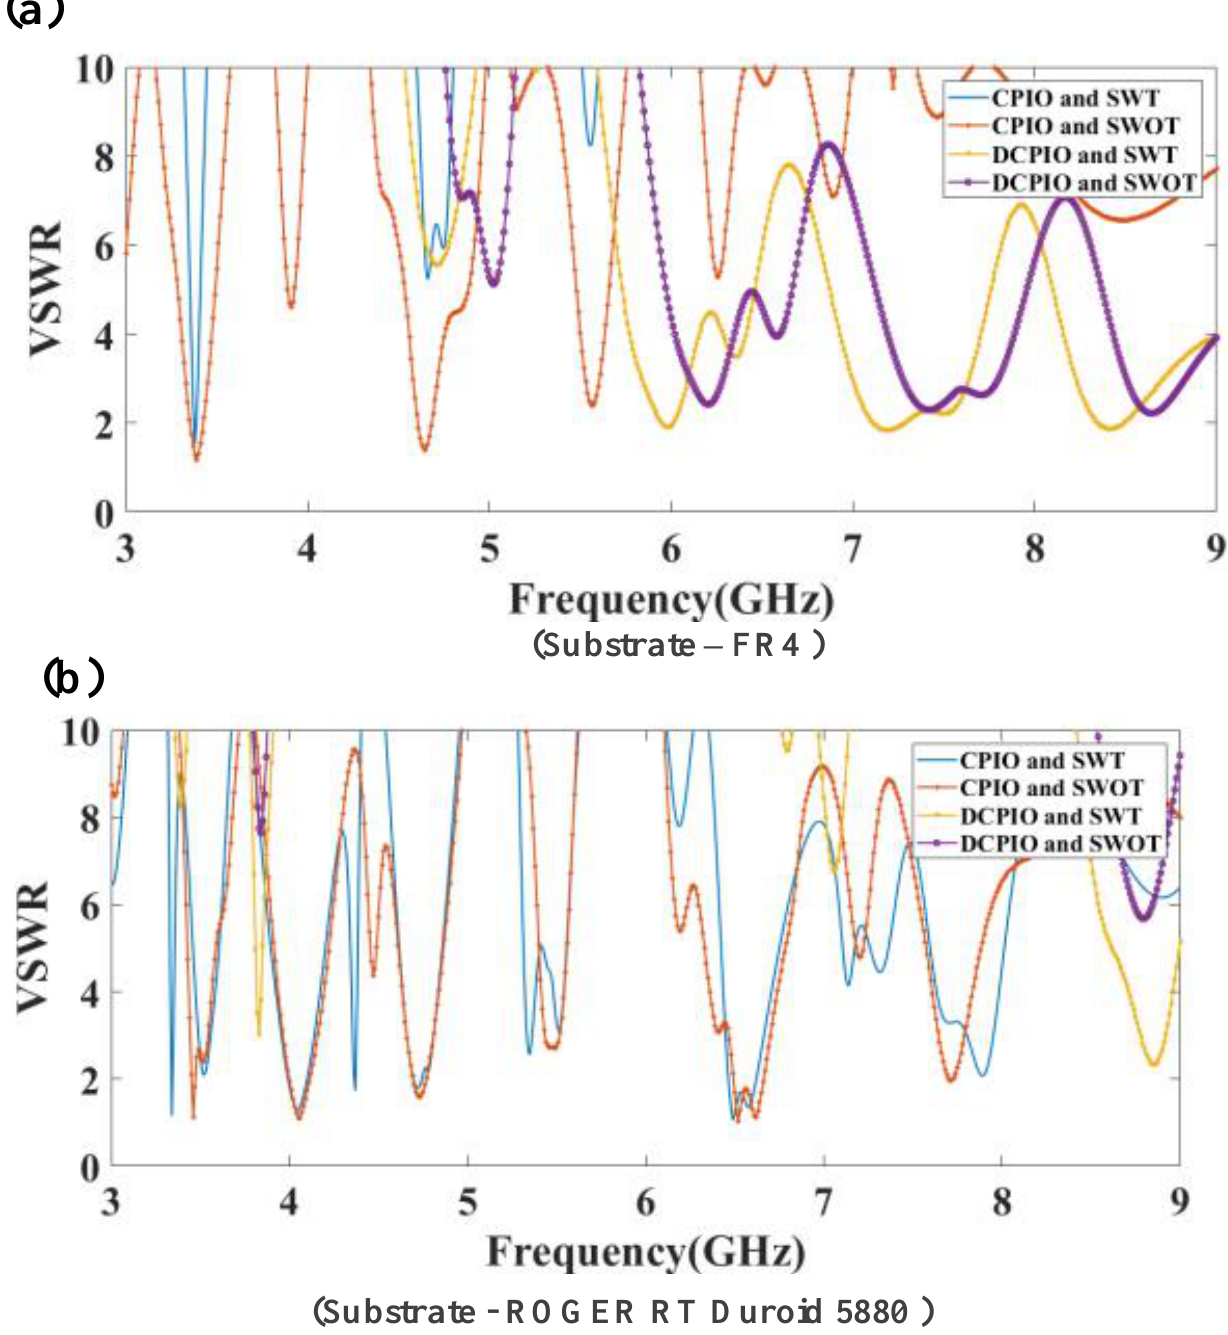
Figure 8. ( a ) The minimum value of the VSWR for the proposed four antenna structures by selecting the substrate as FR4, is 1.51 at 3.38 GHz, 1.18 at 3.39 GHz, 1.83 at 7.27 GHz, respectively, and 2.21 at 8.64 GHz. ( b ) The minimum value of the VSWR for the proposed four antenna structures by selecting the substrate as Rogers RT Duroid 5880 are 1.05 at 6.49 GHz, 1.03 at 6.52 GHz, 2.33 at 8.83 GHz and 5.67 at 8.80